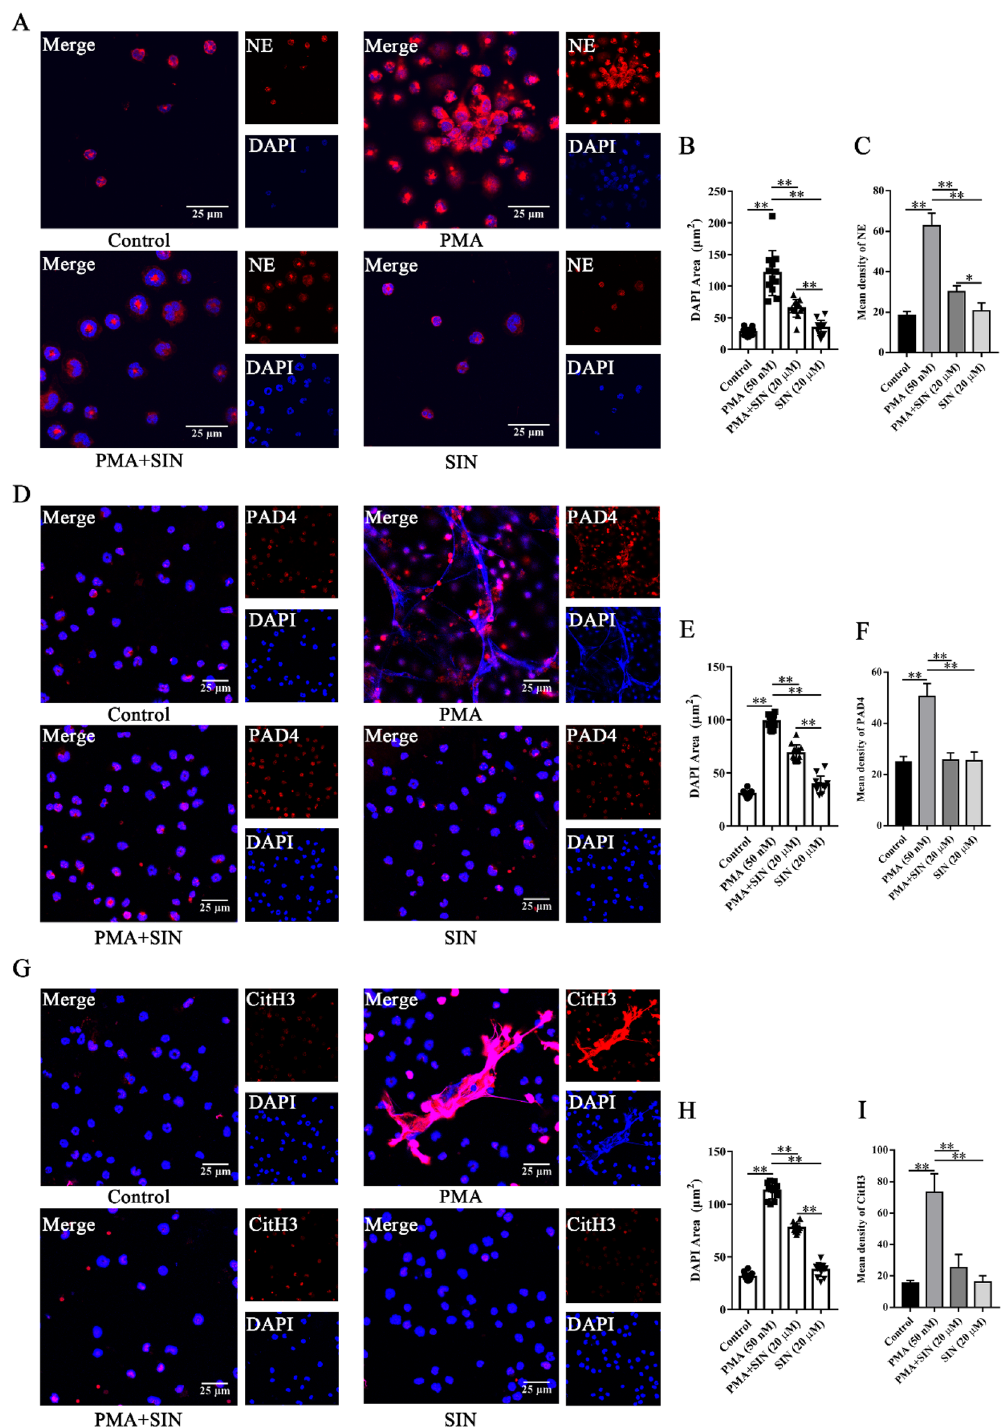
Figure 7. Sinomenine inhibited the formation of NETs in vitro. ( A ) IF staining was used to determine the level of NE in neutrophils. Representative images are shown. ( B ) The nuclear areas in ( A ). The data are shown as the mean ± SD. ( C ) The mean density of NE in ( A ). The data are shown as the mean ± SD (n = 3). ( D ) IF staining was used to determine the level of PAD4 in neutrophils in each group. Representative images are shown. ( E ) The nuclear areas in ( D ). The data are shown as the mean ± SD. ( F ) The mean density of PAD4 in ( D ). The data are shown as the mean ± SD (n = 3). ( G ) IF staining was used to determine the level of CitH3 in the neutrophils in each group. Representative images are shown. ( H ) The nuclear areas in ( G ). The data are shown as the mean ± SD. ( I ) The mean density of CitH3 in ( G ). The data are shown as the mean ± SD (n = 3). *p < 0.05 , **p < 0.01